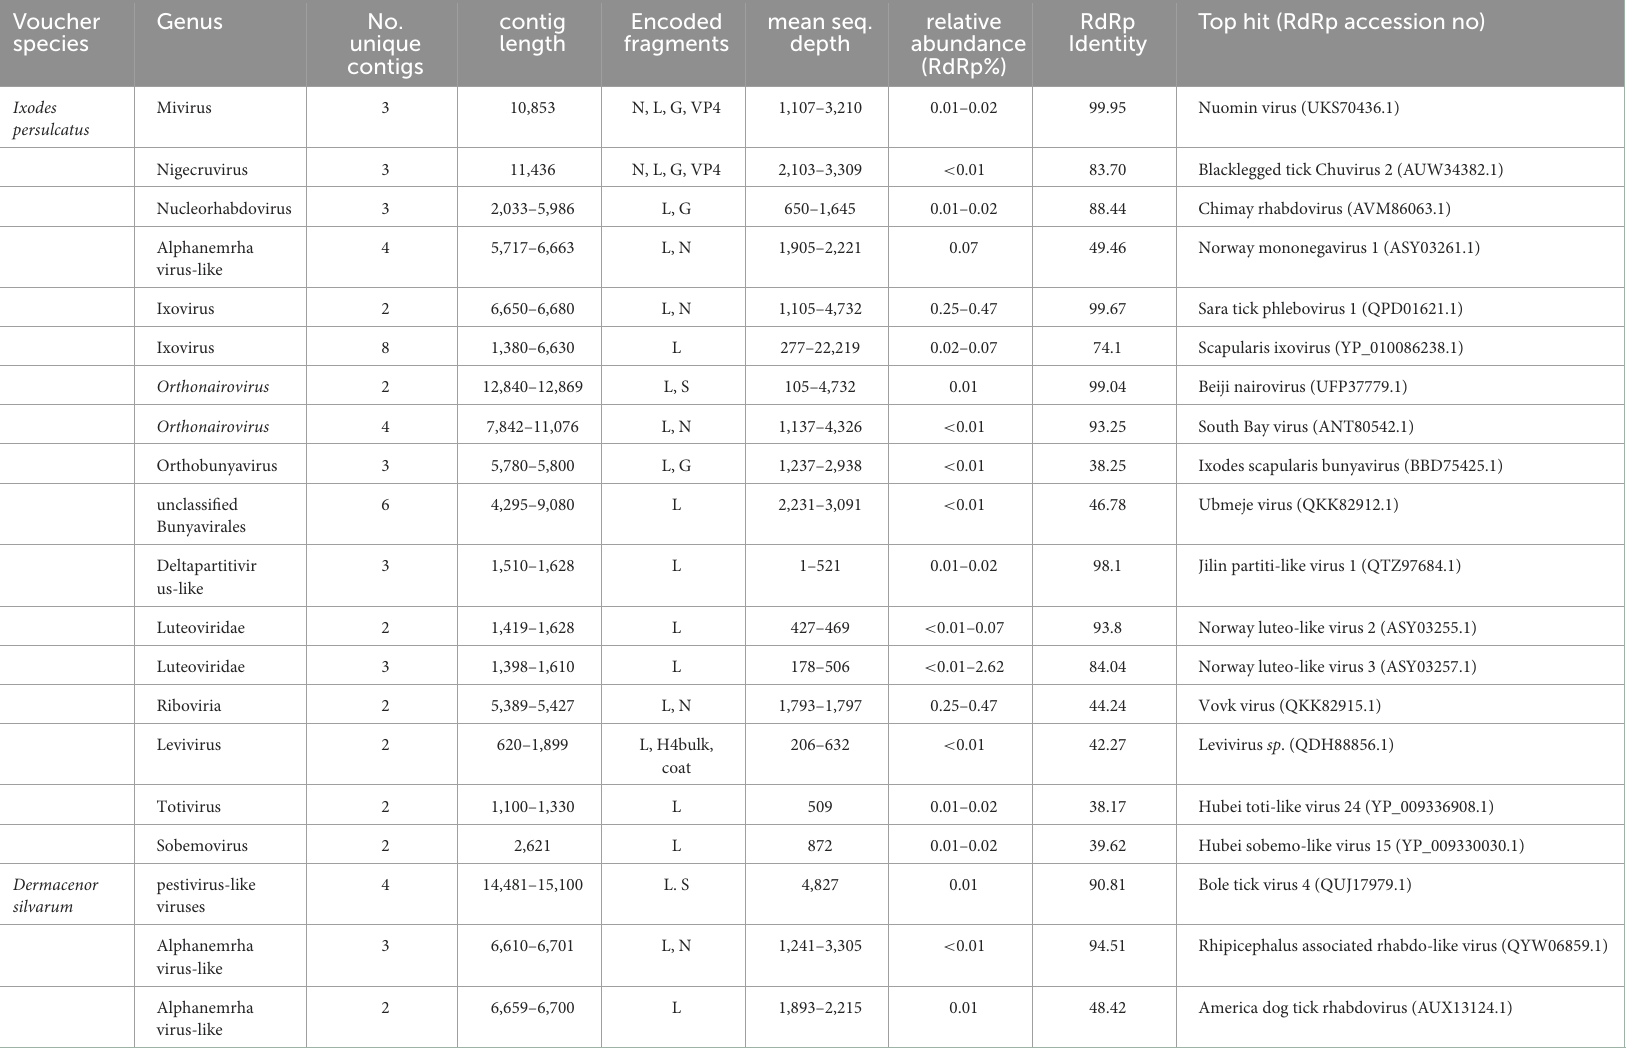
TABLE 1 Virus identified in three dominant tick species in North